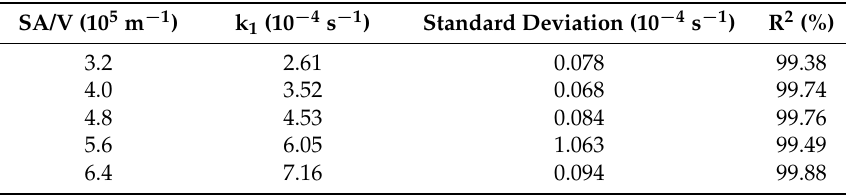
Figure 3. ( A ) ln([H 2 O 2 ]/[H 2 O 2 ] 0 ) ([H 2 O 2 ] 0 = 0.5 mM) as a function of reaction time with different SA/V values of catalyst (3.2–6.4 × 10 5 m − 1 ) at 298 K; ( B ) pseudo first-order reaction rate constant as a function of SA/V at 298 K. The k 1 values were obtained from Figure 3A.